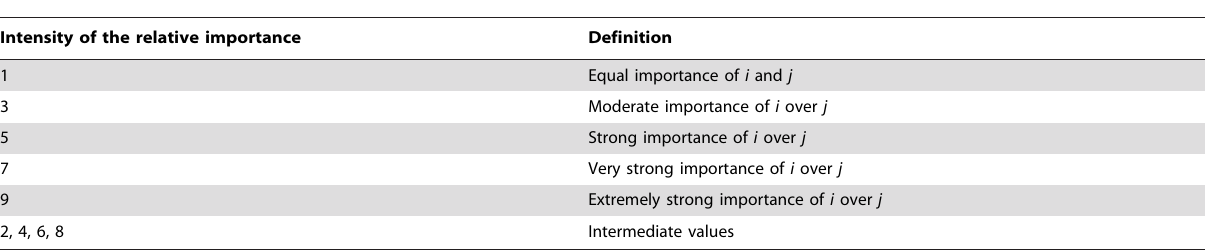
Table 1. AHP pair-wise comparison scale for variables i and j .